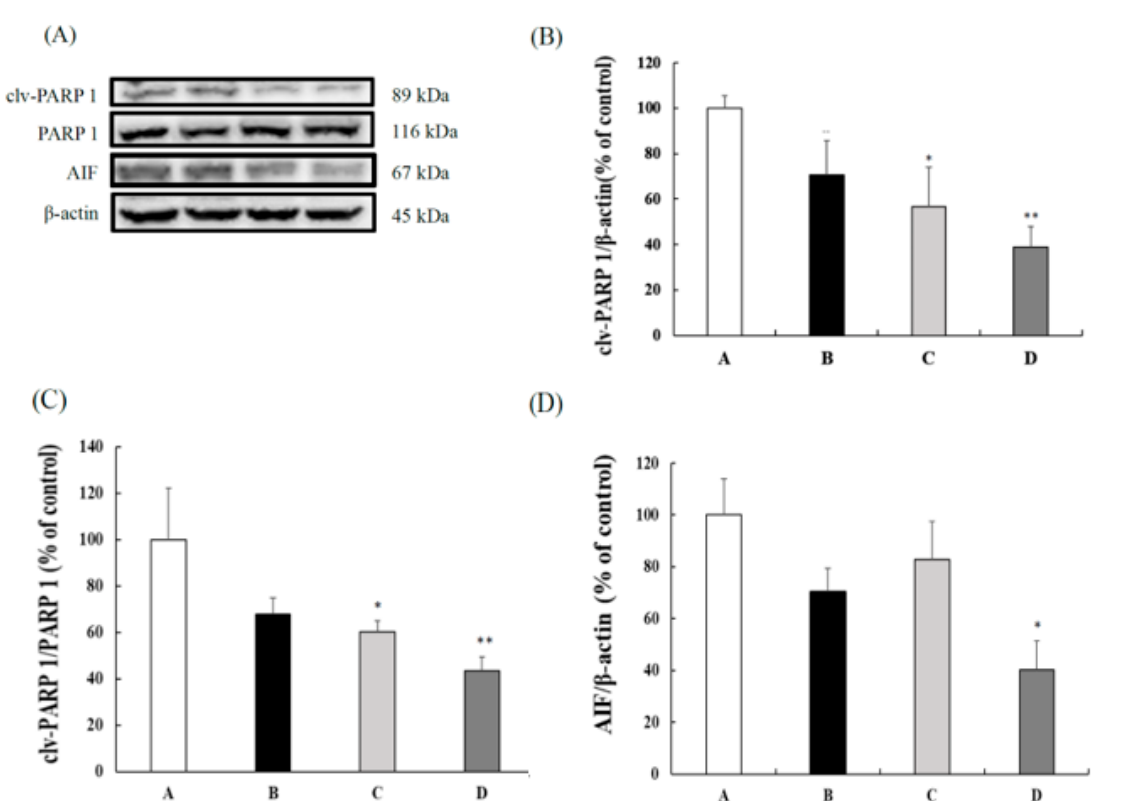
Figure 4. Protein expressions in the livers of 3-month-old male SAMP8 mice fed with different diets for 12 weeks. ( A ) The gel picture of cleaved-PARP 1, PARP 1, AIF, and β -actin expressions. ( B ) cleaved-PARP 1, ( C ) cleaved-PARP 1/PARP 1 ratio, and ( D ) AIF protein expression in livers of different groups. The y axis quantified by the western blot analysis protein of cleaved-PARP 1/ β -actin, cleaved-PARP 1/PARP 1 ratio, and AIF/ β -actin, expressed as the percentage of control. Values are displayed as mean ± S.E.M. and were analyzed by one-way ANOVA ( n = 6/group). * p < 0.05, ** p < 0.005 compared to the control group. A = SAMP8 control, B = 50 mg/kg BW/day CB, C = 100 mg/kg BW/day CB, D = 200 mg/kg BW/day CB.